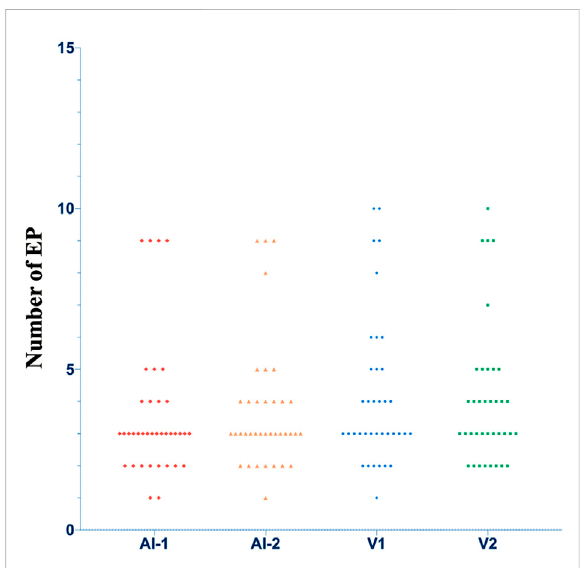
FIGURE 7 ThedistributionsofthenumberofEP.AI,Arti fi cialintelligence algorithm; V, visual